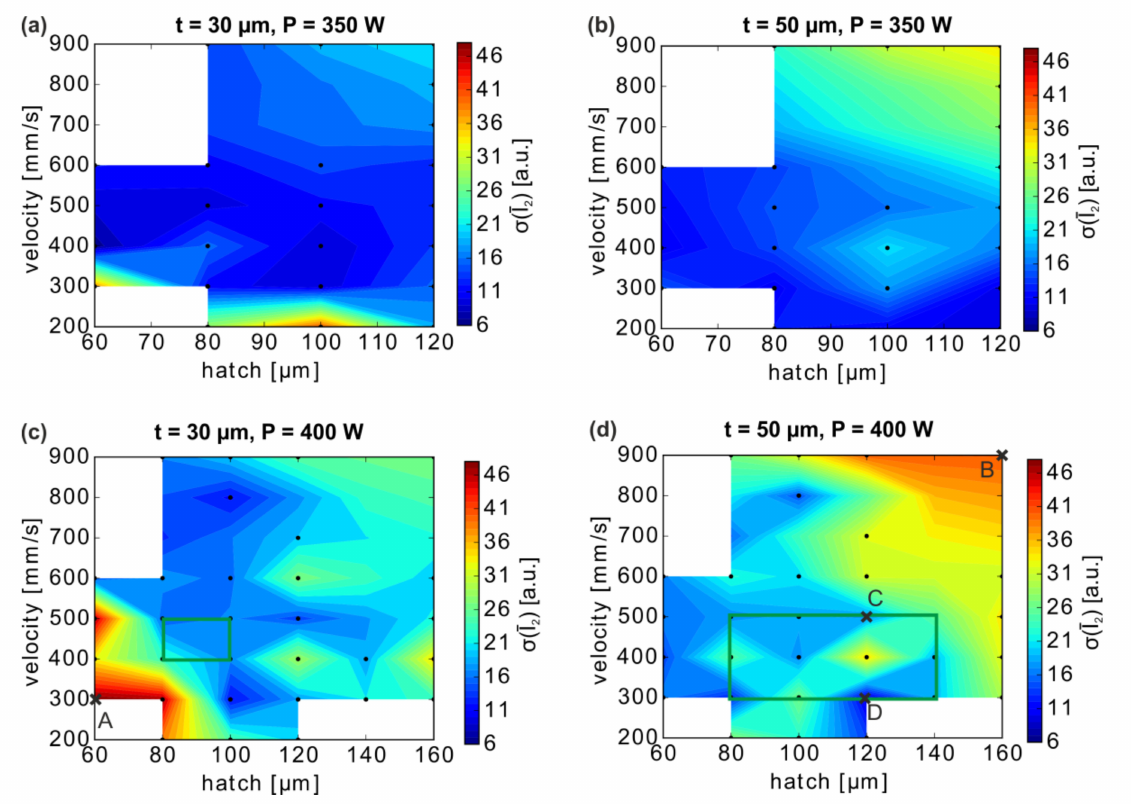
Figure 8. ( a – d ) Standard deviation σ (¯I 2 ) calculated from the layer-wise mean intensities ¯I 2 (cuboids above the supports, 3 mm ≤ b ≤ 14 mm), depending on the layer thickness t and power P. A linear fitting of σ (¯I 2 ) has been applied between the data points (black dots). The positions of two specific specimens are marked with crosses A and B in ( c ) and ( d ), which have a particularly high σ (¯I 2 ). The boxes mark parameter windows and the crosses C and D parameter combinations selected for further component